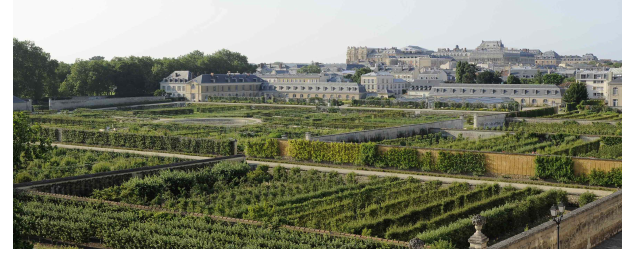
Figure 7. The Potager du Roi ,